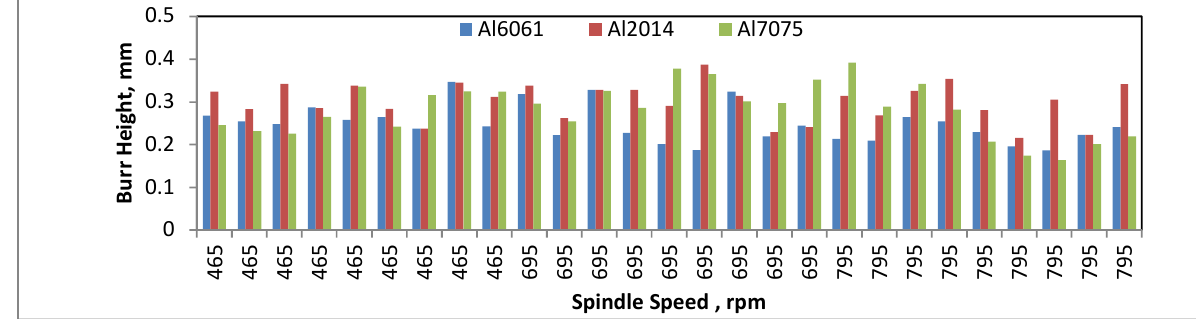
Fig. 7. Effect of variation of the spindle speed on burr height